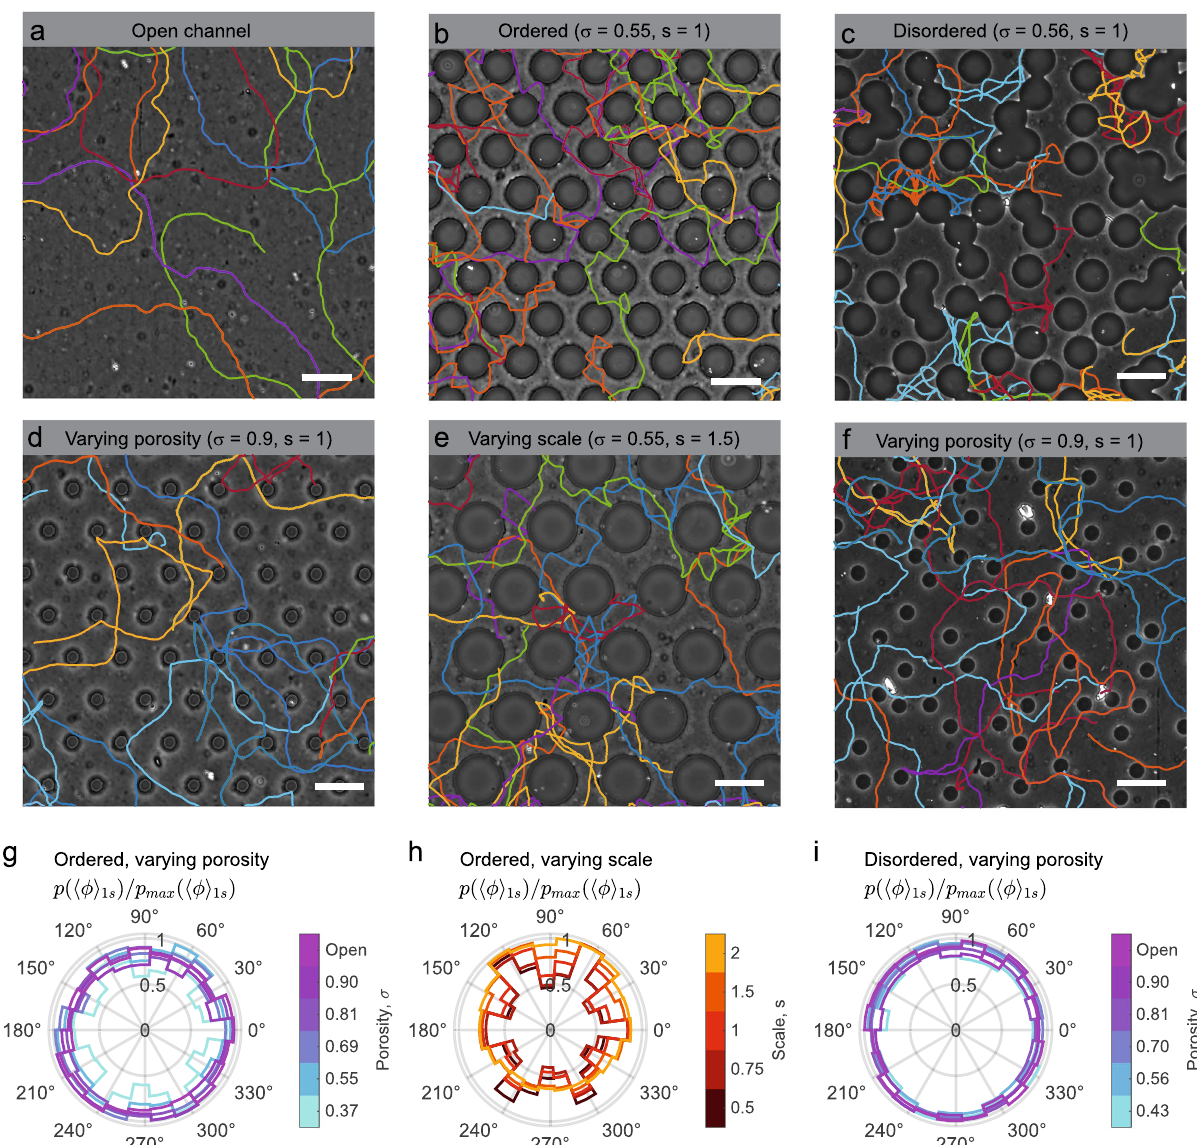
Fig. 1 Porous microstructure frustrates the random walks of swimming cells. a – f Sample cell trajectories in porous micro fl uidic devices for various porosity, scale, and disorder of the obstacle lattice. See Table 1 for a full list of porous micro fl uidic geometries tested. Scale bars, 120 μ m. a Cell trajectories in an open channel (porosity, σ = 1). b Ordered porous medium ( σ = 0.55) with cylindrical pillars of diameter d = 85 μ m, arranged in a hexagonal lattice with a lattice spacing c = 120 μ m (scale, s = 1). c Disordered porous medium ( σ = 0.55, s = 1), where d and average lattice spacing are similar to ( b ). d Porosity is varied by modifying the pillar diameters ( d = 40 μ m), while holding the lattice spacing constant ( c = 120 μ m). e Identical to ( b ), but with all features scaled up by a factor s = 1.5. f Identical to ( c ), but with increased porosity by reducing the pillar diameters to d = 20 μ m. g – i Normalized polar probability density of cell swimming directions in various geometries: g ordered lattice with varying porosity ( s = 1), h ordered lattice with varying scale ( σ = 0.55), and i disordered media with varying porosity ( s = 1). Instantaneous swimming direction vectors are averaged over a 1 s interval within the ballistic regime of the cell trajectories to obtain average swimming directions, 〈 ϕ 〉 1 s . Cell trajectories were randomly sampled from the entire cell population (Supplementary Fig. 1), and the probability, p ( 〈 ϕ 〉 1 s ), is normalized by its maximum value, p max ( 〈 ϕ 〉 1 s